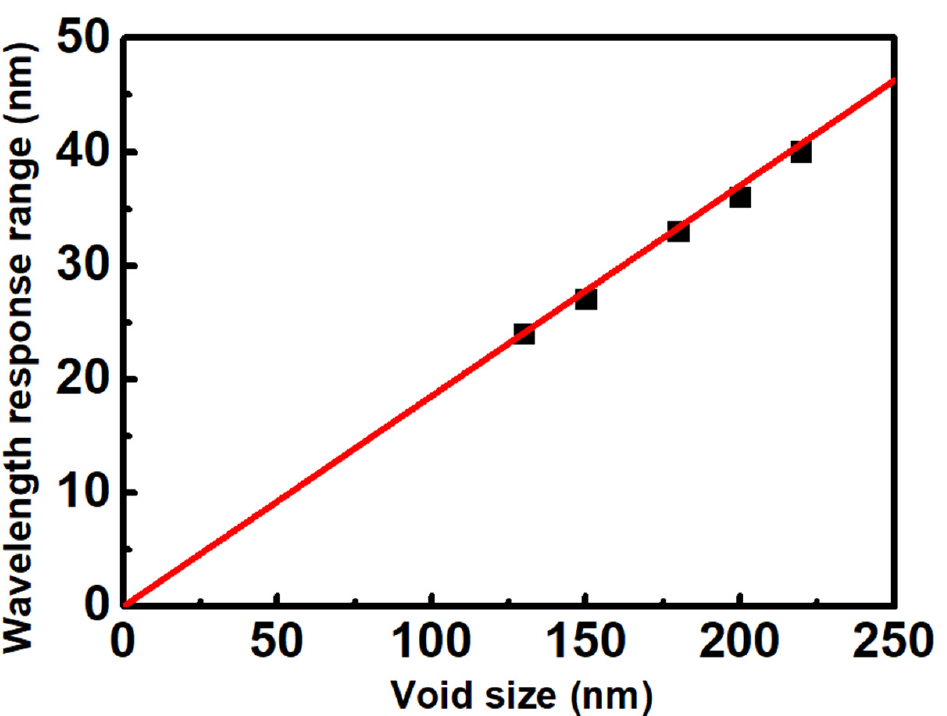
Figure 8. The relationship between wavelength response range and void sizes predicted by Bragg– Snell’s law and calculated by FDTD method.